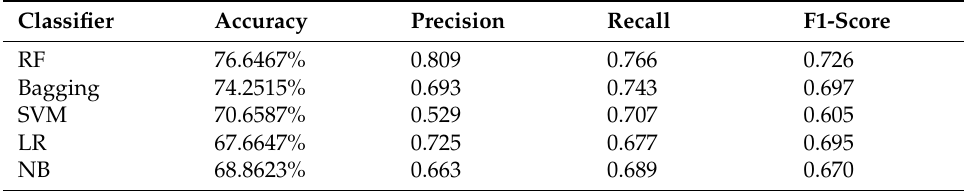
Table 13. Experiments with ML models and Word2Vec on original